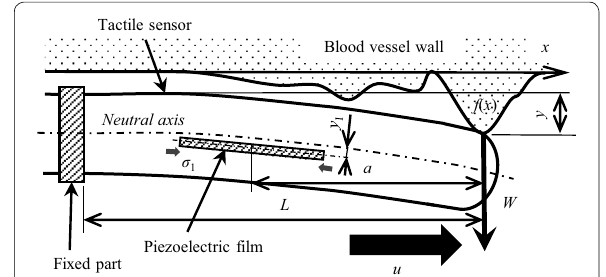
Fig. 6 Specifications of catheter-type tactile sensor